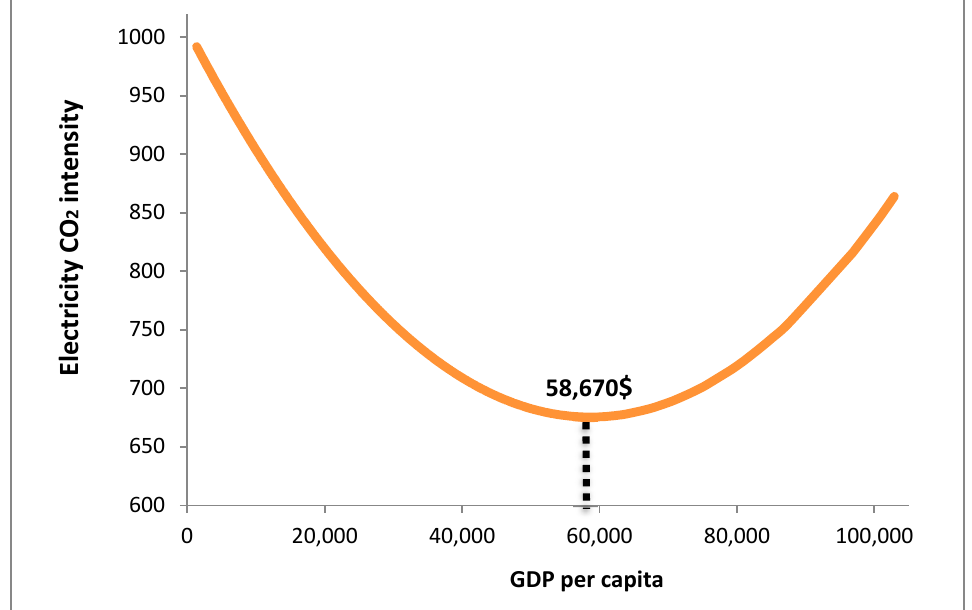
Figure 3. Electricity CO 2 intensity vs. polynomial function of GDP per capita.